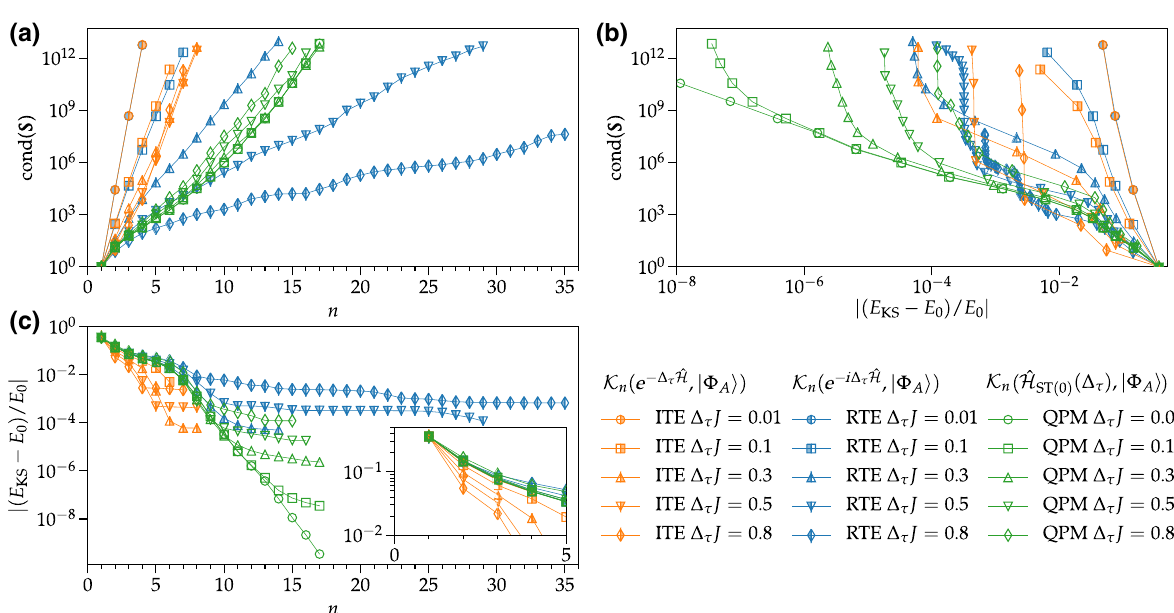
ˆ H is the spin-1 / 2 Heisenberg model on